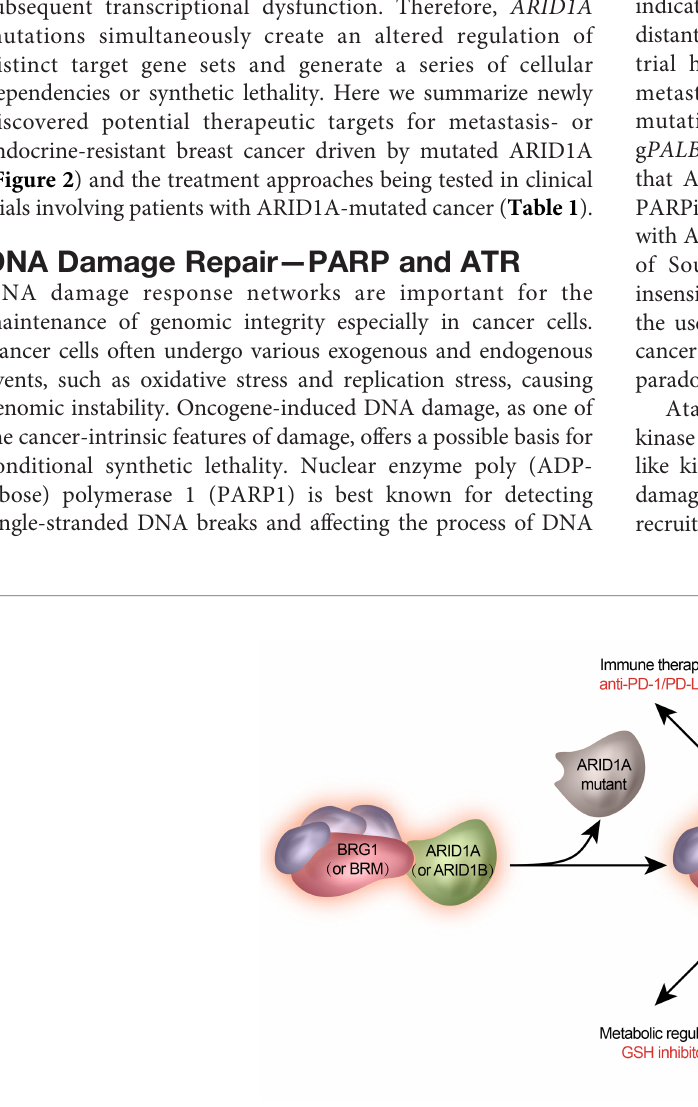
FIGURE 2 | Potential treatments of ARID1A-mutated metastatic breast cancer. ARID1A mutation gives rise to speci fi c signaling pathways and cellular functions. They are selected as therapeutic targets against ARID1A